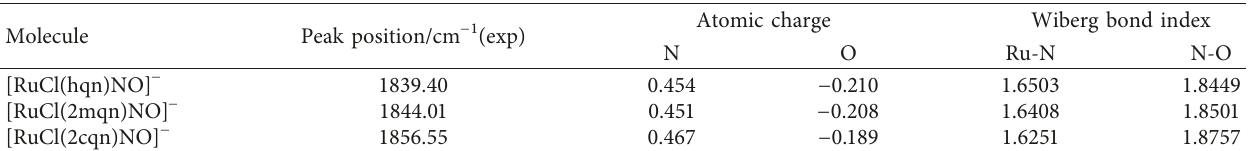
(a), [RuCl 3 (2mqn)NO] 3 (hqn)NO] −